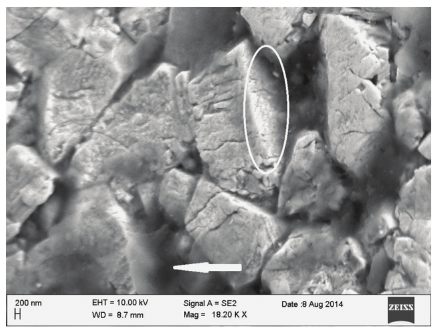
Figure 10: Corrosive degradation of WC grain (white oval); white arrow shows the coal/rock intermixed binder